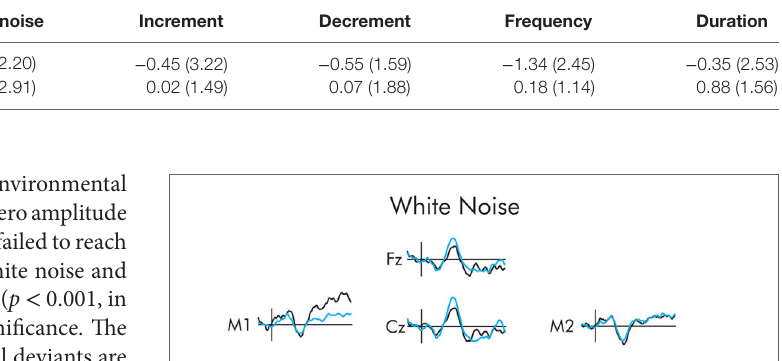
TaBle 2 | Mean amplitudes (SD in parentheses) at the Cz electrode site for the difference waves at the time interval of the P3a. environmental sounds White noise increment Decrement Frequency Duration Controls